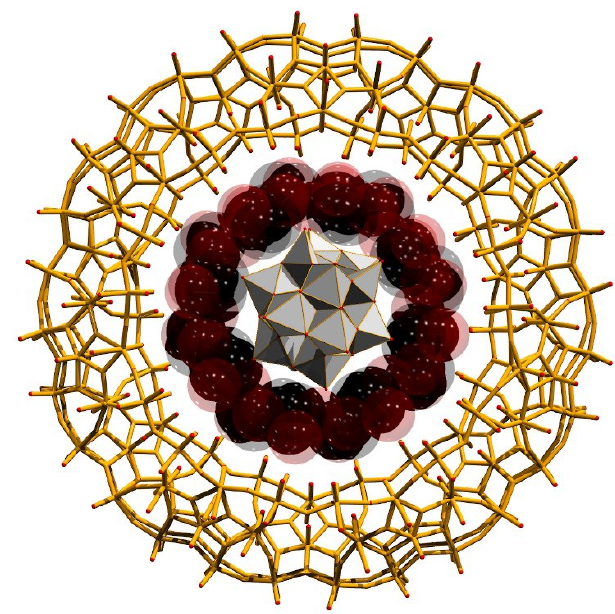
Figure 7. Representation of the [Mo 154 O 462 H 14 (H 2 O) 70 ] 14− molecular wheel which hosts a Dawson anion, [P 2 W 18 O 62 ] 6− , capped by two γ-CDs moieties.